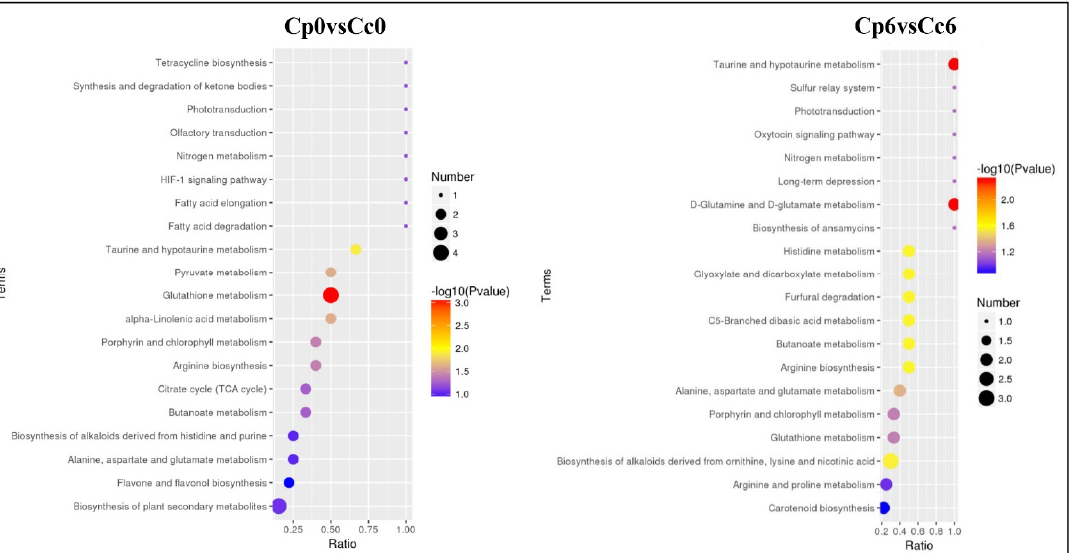
Figure 9. KEGG enrichment analysis of DAMs in the cold-treated C. pubescens and C. chinense pepper seedlings. The ordinate indicates the pathway name, and the abscissa is the enrichment factor. The size of the circle indicates the number of genes enriched in the KEGG pathway, and the color of the circle represents the p-value.